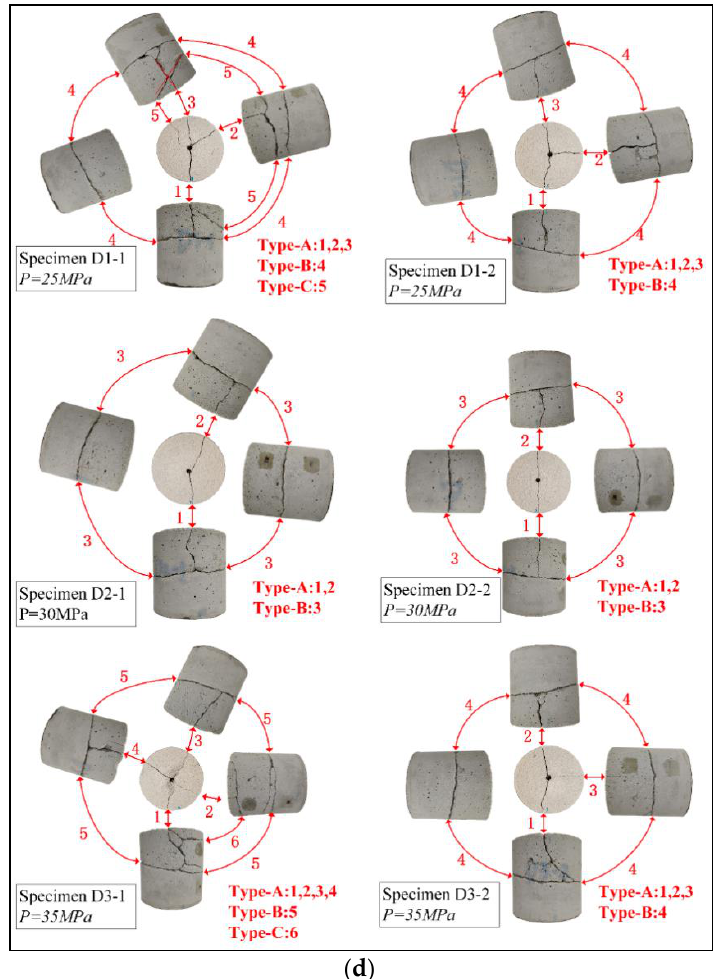
Figure 5. The unfolded images of fractures on the surfaces of specimens after experiments. ( a ) Experimental results of group A; ( b ) experimental results of group B; ( c ) experimental results of group C; ( d ) experimental results of group D.